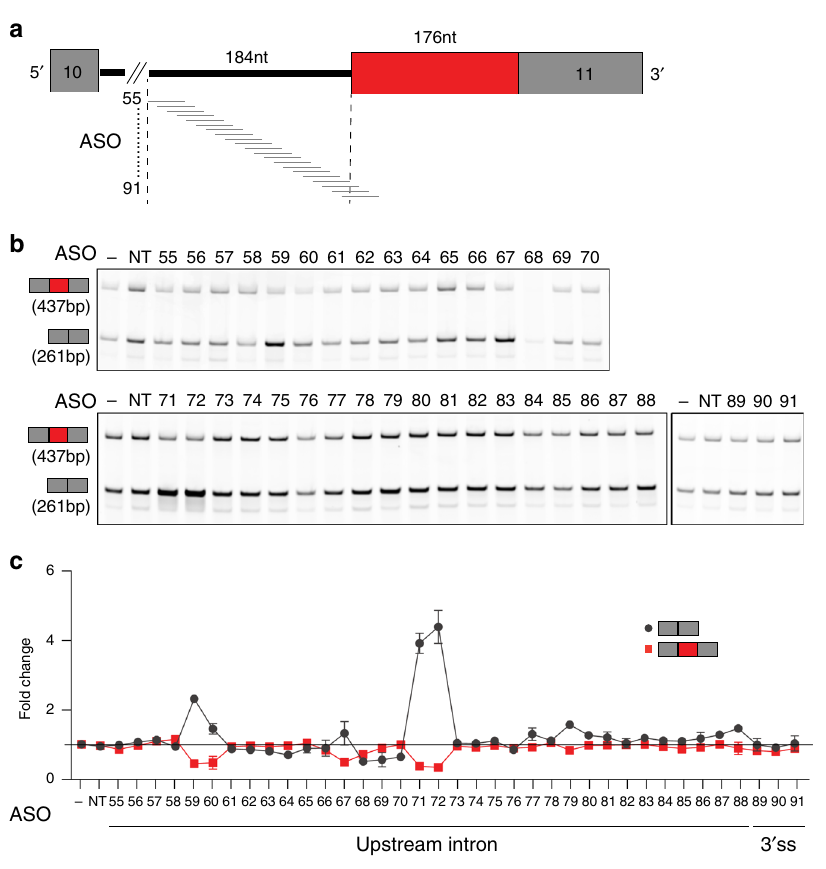
Fig. 3 ASO walk targeting the NMD-inducing alternative 3 ′ ss in SYNGAP1 . a Diagram of ASO walk. The target region spans 184 nt of intronic sequences upstream as well as across the non-productive alternative 3 ′ ss in SYNGAP1 . Black lines denote introns, gray rectangles denote constitutive exons, and red rectangle denotes non-productive alternative region. b A representative RT-PCR PAGE from HEK293 cells transfected with a total of 37 18-mer ASOs (shown in panel a ) and a non-targeting ASO control (NT) at 80 nM concentration or no ASO control ( − ) for 24 h. The top band (437 bp) corresponds to the non-productive mRNA that results from the alternative 3 ′ ss and the bottom band (261 bp) corresponds to the productive mRNA that results from the canonical splicing of exon 11 ( n = 2 biologically independent samples over two independent experiments). c Graph depicting the fold decrease of SYNGAP1 non-productive mRNA based on densitometric quanti fi cation of RT-PCR products (red squares, n = 2) from panel b and the fold increase over no ASO control ( − ) of SYNGAP1 productive mRNA determined by TaqMan qPCR (gray circles, n = 2). Data are presented as mean values ±SD. Results show an inverse correlation between the reduction of non-productive mRNA and the increase of productive mRNA. ASO sequences are in Supplementary Data 4. Source data are provided as a Source Data fi